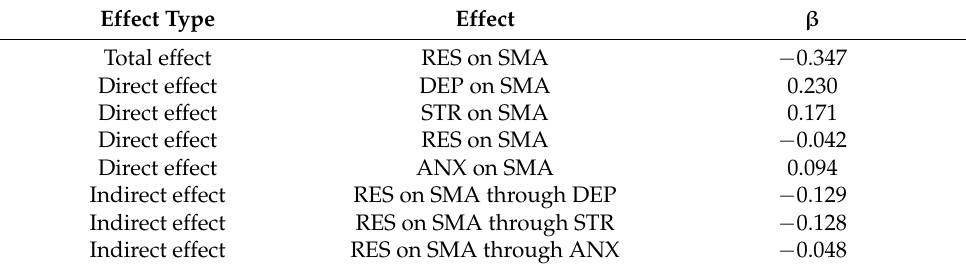
Table 8. Total, direct and indirect effects on SMA and their